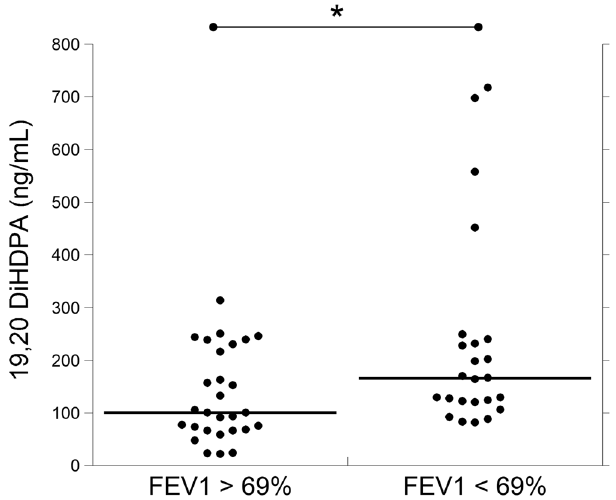
Figure 4. Comparison of salivary levels of 19,20 DiHDPA between CF patients with FEV1 > 69% (n = 41) and FEV1 < 69% (n = 28). DiHDPA was not detectable (< 0.1 ng/mL) in 13 patients with FEV1 > 69% and in 4 patients with FEV1 < 69%. FEV1: forced expiratory volume in the 1st second. *p < 0.01.